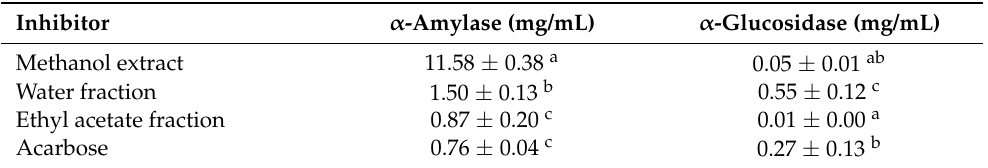
Table 1. Inhibitory activity (IC 50 ) of H. tuna methanol extract, ethyl acetate fraction, water fraction, and acarbose against α -amylase and α -glucosidase.